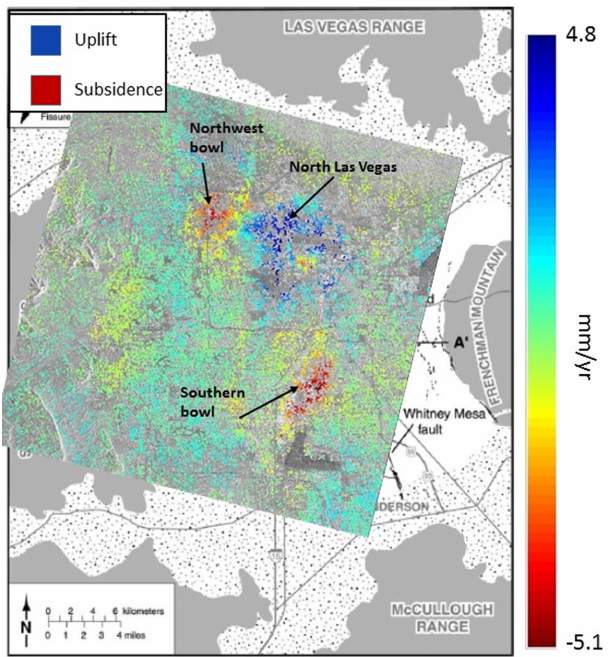
Figure 2. PS-InSAR interferogram showing rate of surface uplift and subsidence for the period